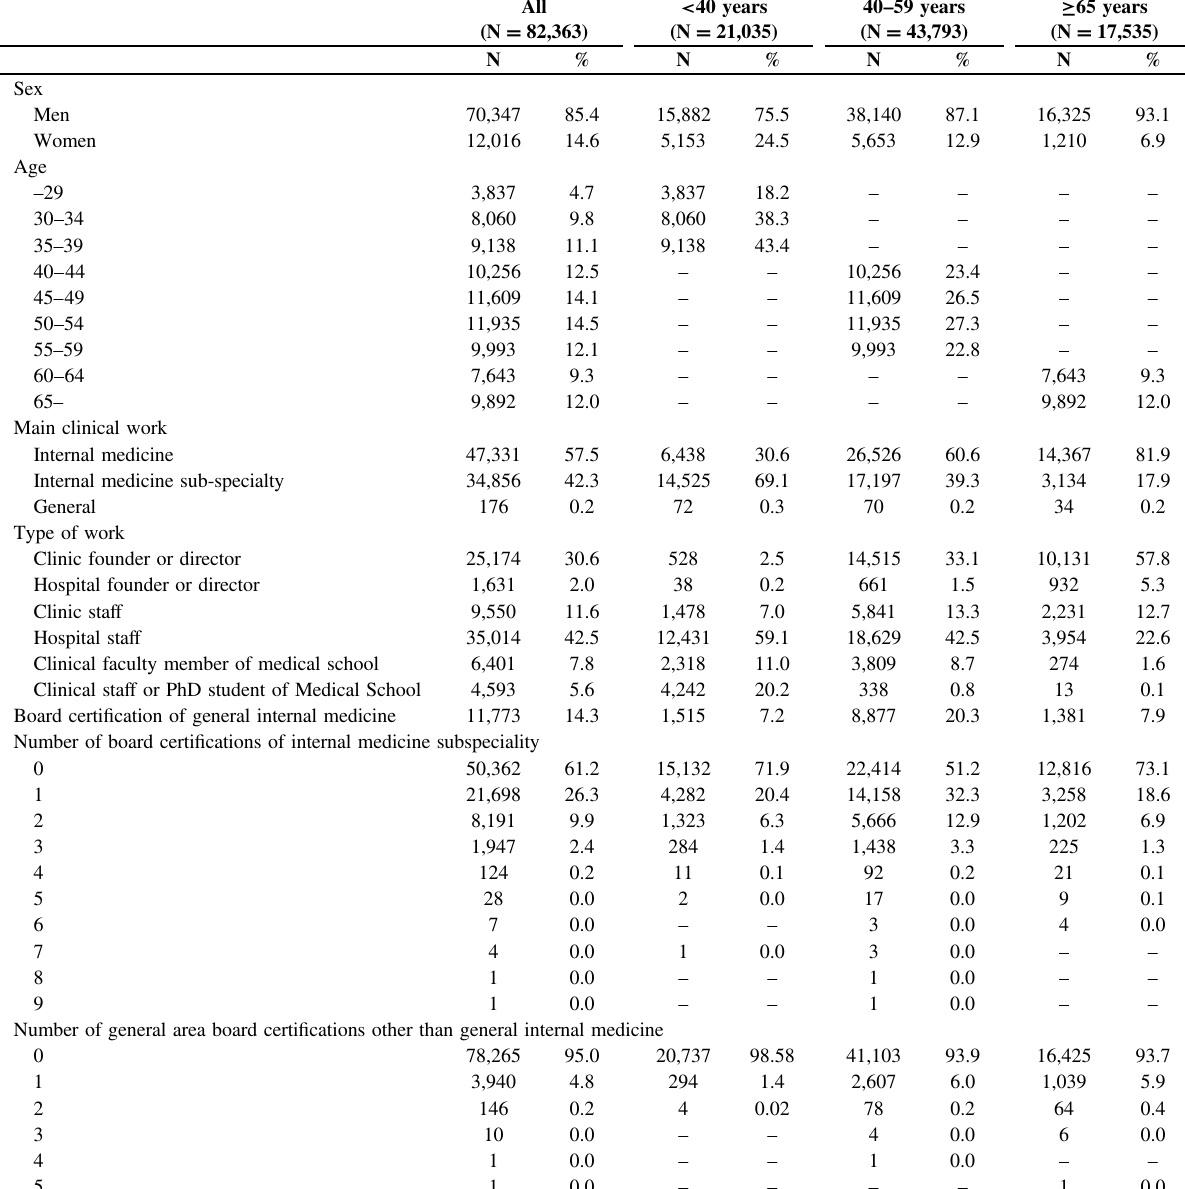
Table 2 Characteristics of Internal medicine doctors (Year